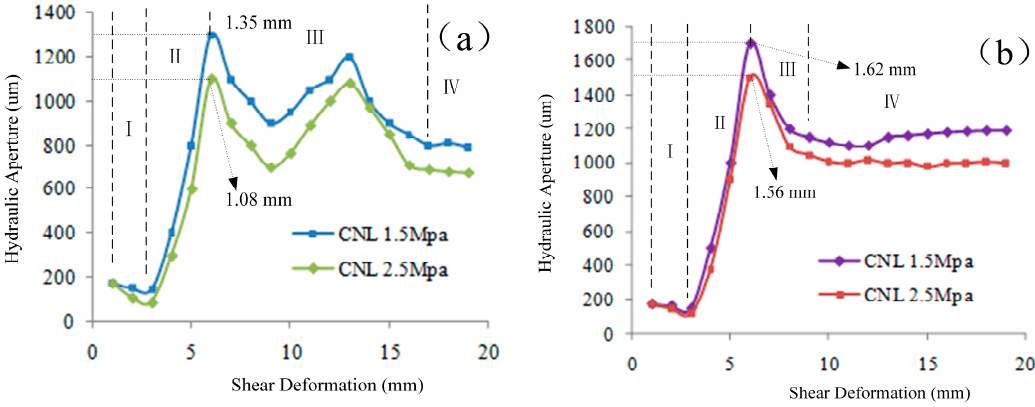
Figure 9. Hydraulic aperture curves under different normal stresses when seepage pressure is 1.0 MPa: ( a ) joint roughness is 15°; ( b ) joint roughness is 30°.